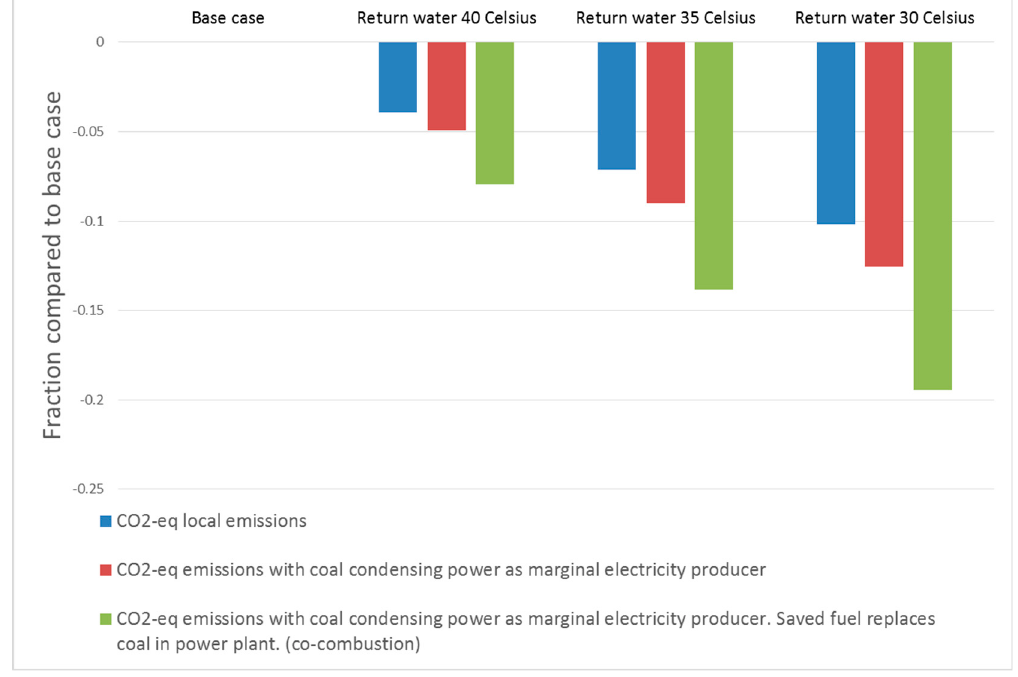
Figure 12. Modelled changes in GHG emissions for the examined cases with three di ff erent system